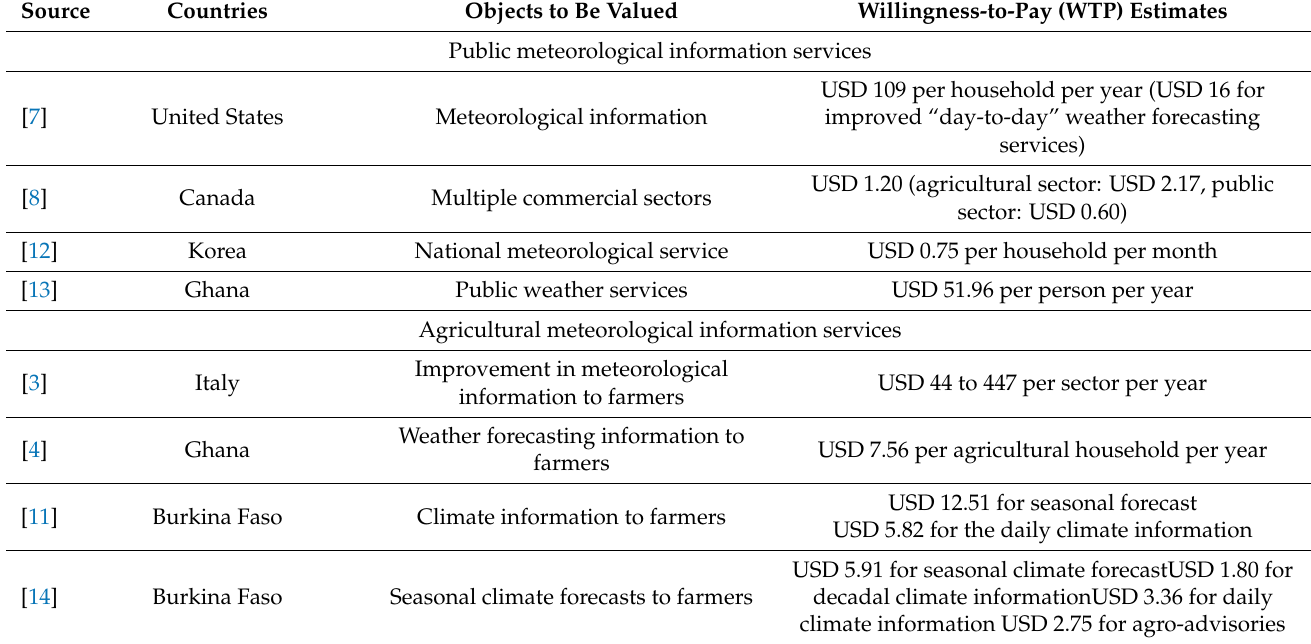
Table 1. Literature review of contingent valuation